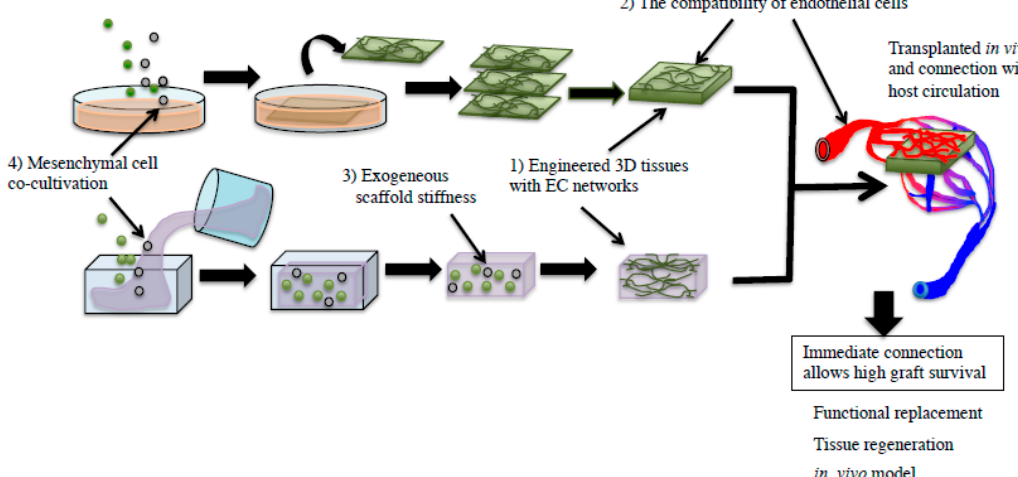
Figure 1. Factors associated with connection and perfusion of transplanted tissues. Using tissue engineering technology, 3D tissues were formed and transplanted. Factors affecting host–donor vasculature connection and perfusion are: (1) Engineered 3D tissues with endothelial cell (EC) networks, (2) compatibility of endothelial cells, (3) exogenous scaffold stiffness, and (4) mesenchymal cell co-cultivation. The transparent circles were indicated as mesenchymal cells. The green circles were indicated as ECs.